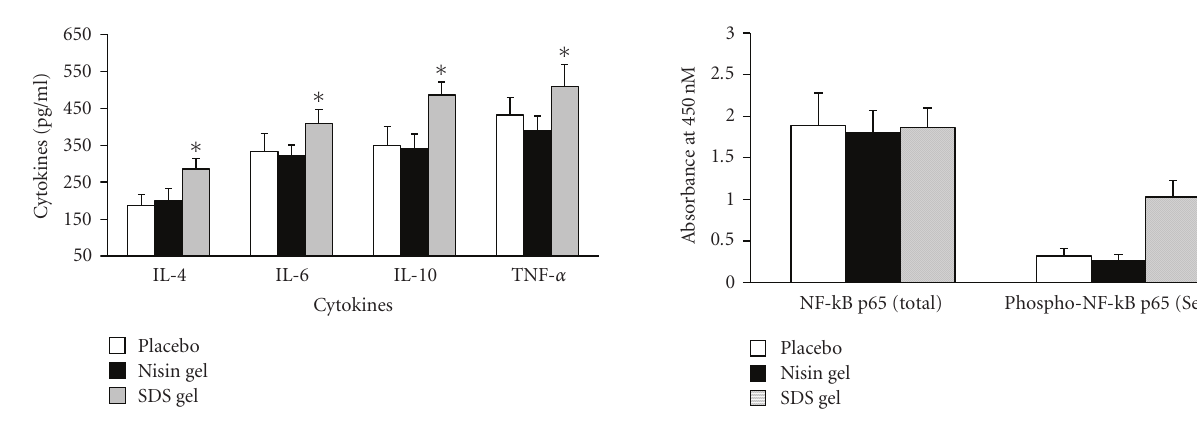
Figure 10: Determination of total and phosphorylated NF- k B p65 protein levels by ELISA as per the protocol described in materials and methods. No change was observed in total NF- k B levels. However, the phosphorylated NF- k B protein levels were significantly elevated in SDS gel administered animals.